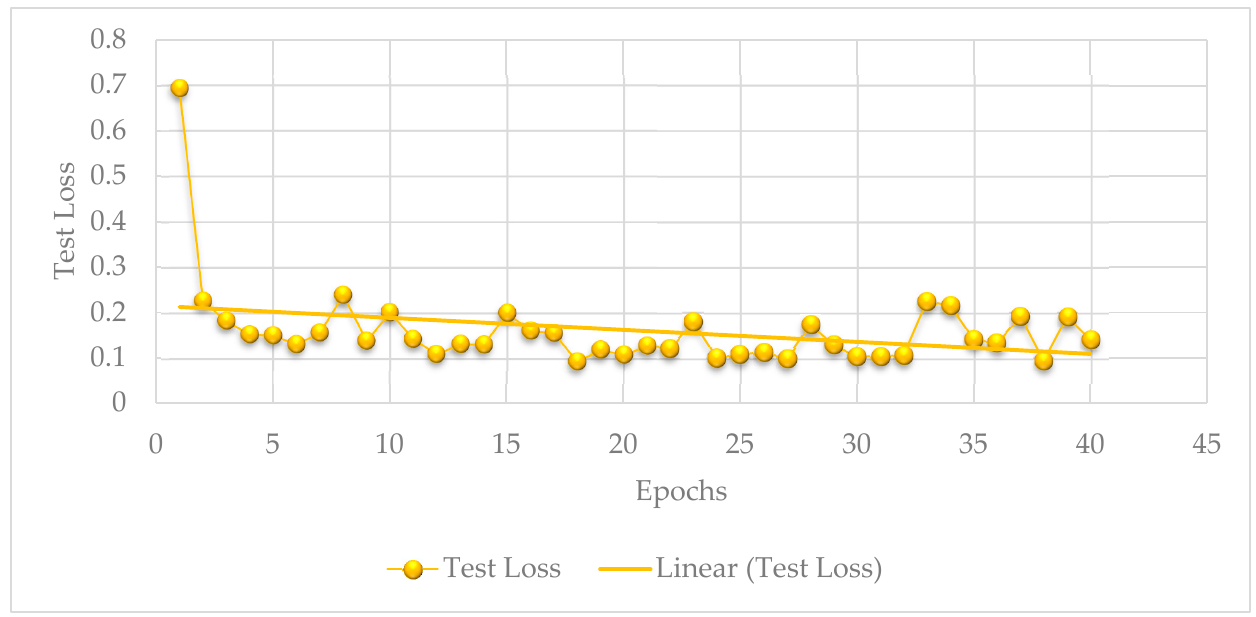
Figure 11. Graph showing test loss vs. epoch characteristics.